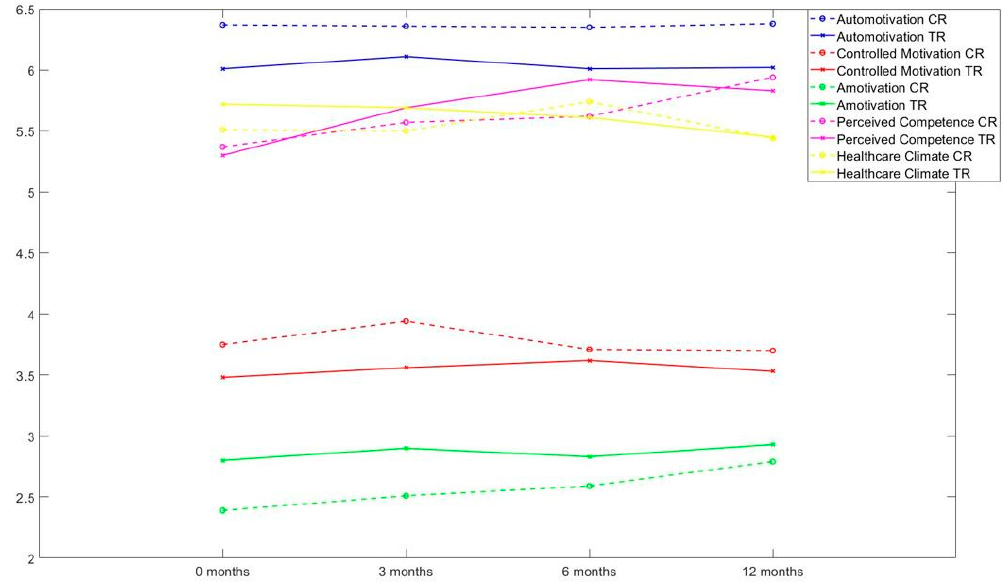
Figure 3. Motivational changes in the TR and CR groups over time.